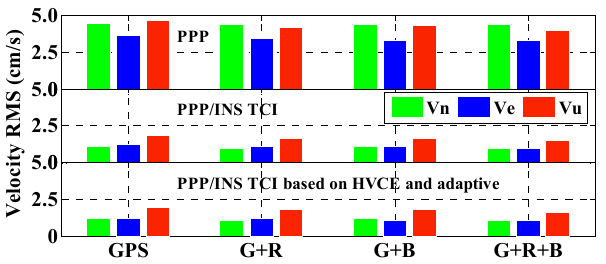
Figure 10. RMS of velocity offsets from PPP mode ( top ), the PPP/INS tightly coupled integration mode without ( middle ) and with the HVCE adaptive scheme ( bottom ) using GPS, G + R, G + B, and G + R + B GNSS data. Remote Sens. 2016 , 8 , 553